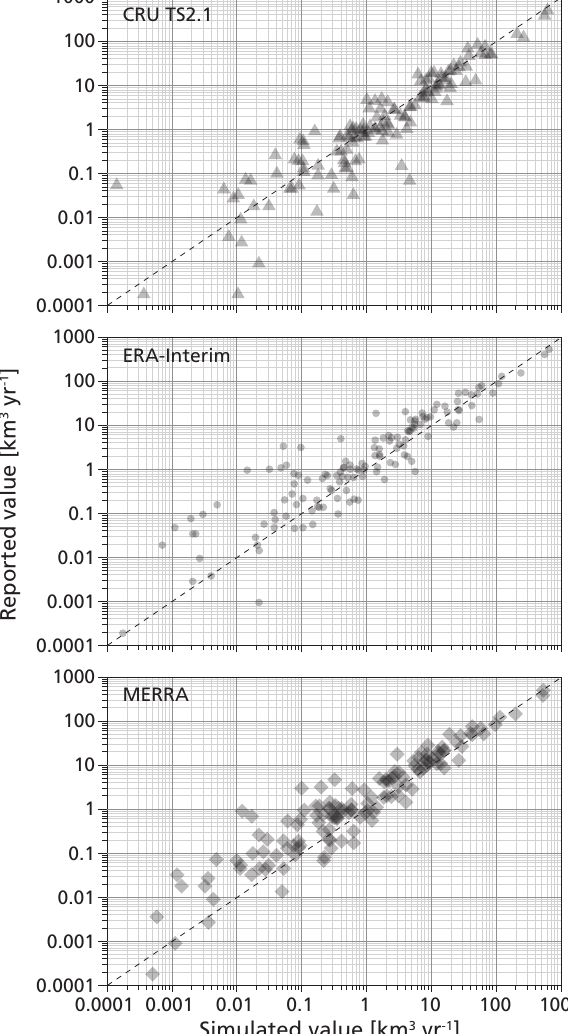
Fig. 2. Comparison of simulated IWR to reported statistics [km 3 yr − 1 ] per country for the year 2000 ( N = 212). IWR was simu- lated with the CRU TS2.1, ERA-Interim and MERRA climate re- spectively. Reported statistics was obtained from the FAO AQUA- STAT database (http://www.fao.org/nr/water/aquastat/main/index. stm). The dashed line represents the 1 : 1 slope. Simulated IWR with the CRU TS2.1 is provided for a reference and is not included in our overall